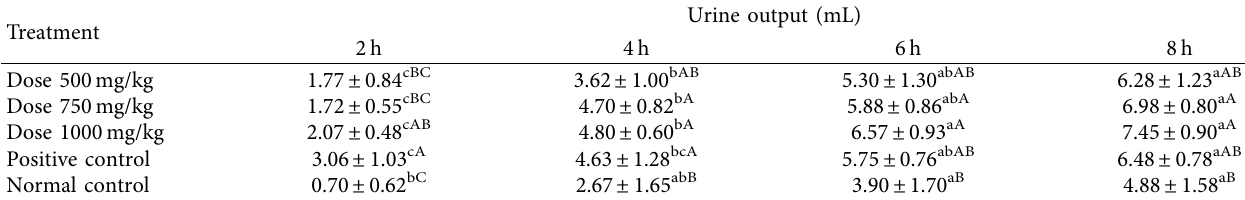
Table 4: Urine output from the rats treated with microencapsulated product of M. stenopetala leaves extract. Treatment